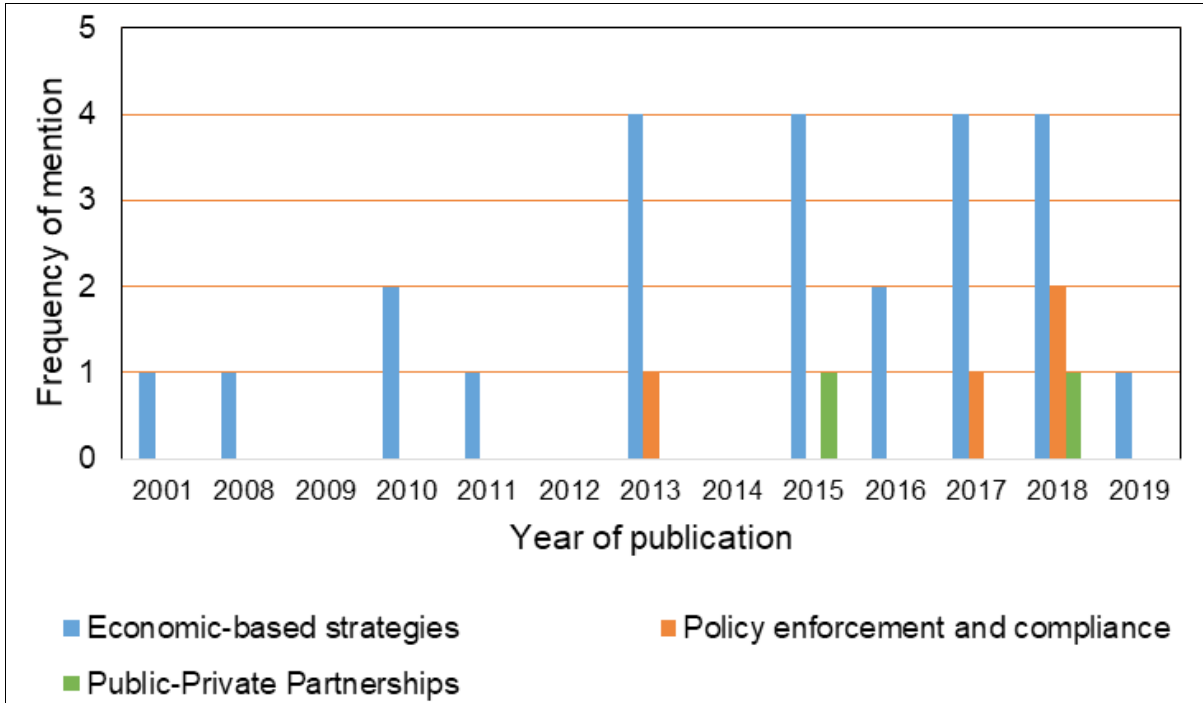
Frequency of mention of economic-based strategies, policy enforcement and compliance, and public–private partnerships in the selected literature over the past two